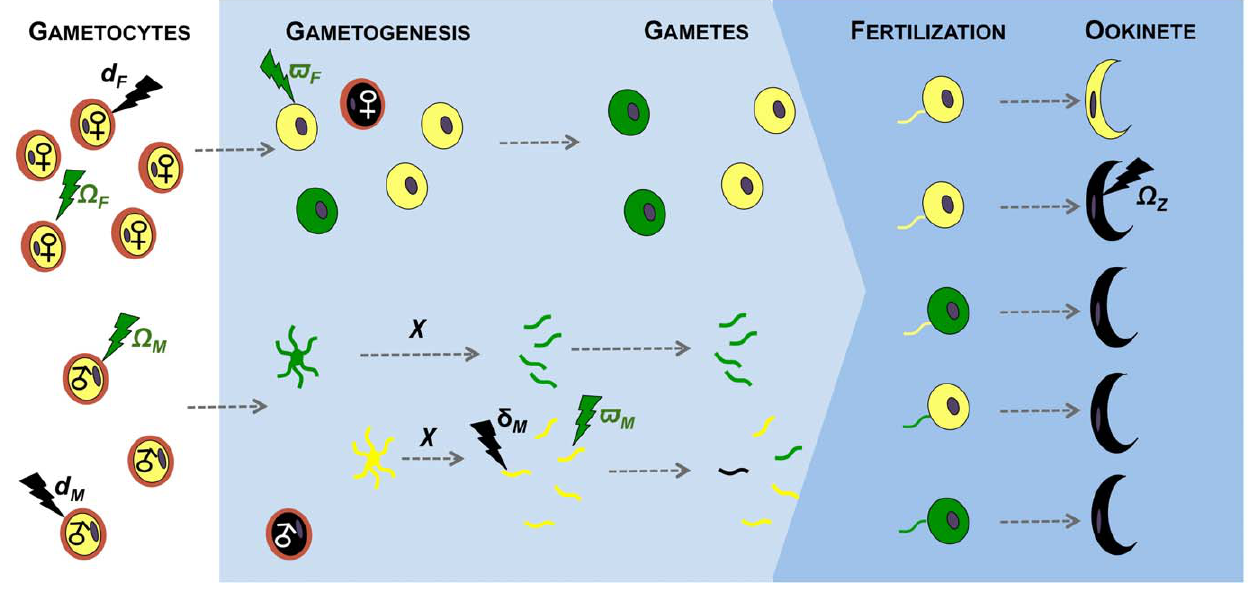
Figure 1. Effects of immunity on gametogenesis and fertility of malaria parasites. The effects of transmission-blocking immune factors on the sexual development of malaria parasites investigated in our model. Female and male gametocytes circulating in the host (white background) undergo gametogenesis when taken up by a mosquito vector (blue background). Each male gametocyte differentiates into x gametes ( x # 8) and each female gametocyte produces one gamete. Male gametes locate and fertilise female gametes, and the resulting zygotes develop into ookinetes. Immune factors circulating in the host can act on males and females throughout their sexual development, from gametocytes to zygotes. The developmental stages of females are shown above the stages of males and each individual gametocyte/gamete is shown in the same relative position throughout development. The effects of immune factors (lighting) on sexual stages can either be cryptic (i.e. render gametocytes/gametes dysfunctional; green), or fatal (i.e. gametocytes/gametes die; black). Healthy, unaffected, parasites are represented in yellow, dysfunctional parasites in green, and dead parasites in black. Immune factors kill female gametocytes with probability d F and male gametocytes or gametes with probabilities d M or d M , respectively. Dead sexual stages do not participate further in the mating pool. Immune factors render female gametocytes and gametes dysfunctional with probabilities V F and v F respectively, and male gametocytes and gametes with probabilities V M and v M , respectively. Dysfunctional gametocytes/gametes participate in the mating pool and can be fertilized as for healthy gametes, however zygotes are unviable and die before reaching the ookinete stage. Immune factors can also directly lead to zygote death with probability V Z . All possible fertilization scenarios are represented: mating between two healthy gametes, mating between one healthy and one dysfunctional gamete and mating between two dysfunctional